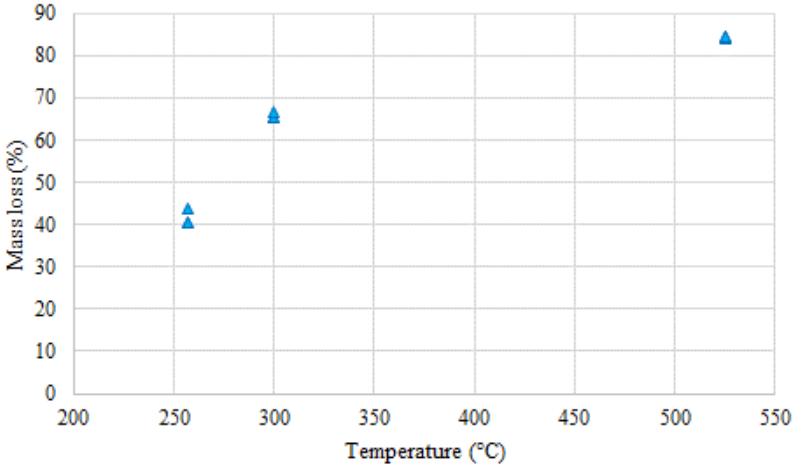
Figure 15. Mass loss of Miscanthus after a torrefaction process in a CO 2 atmosphere using an electrical furnace.